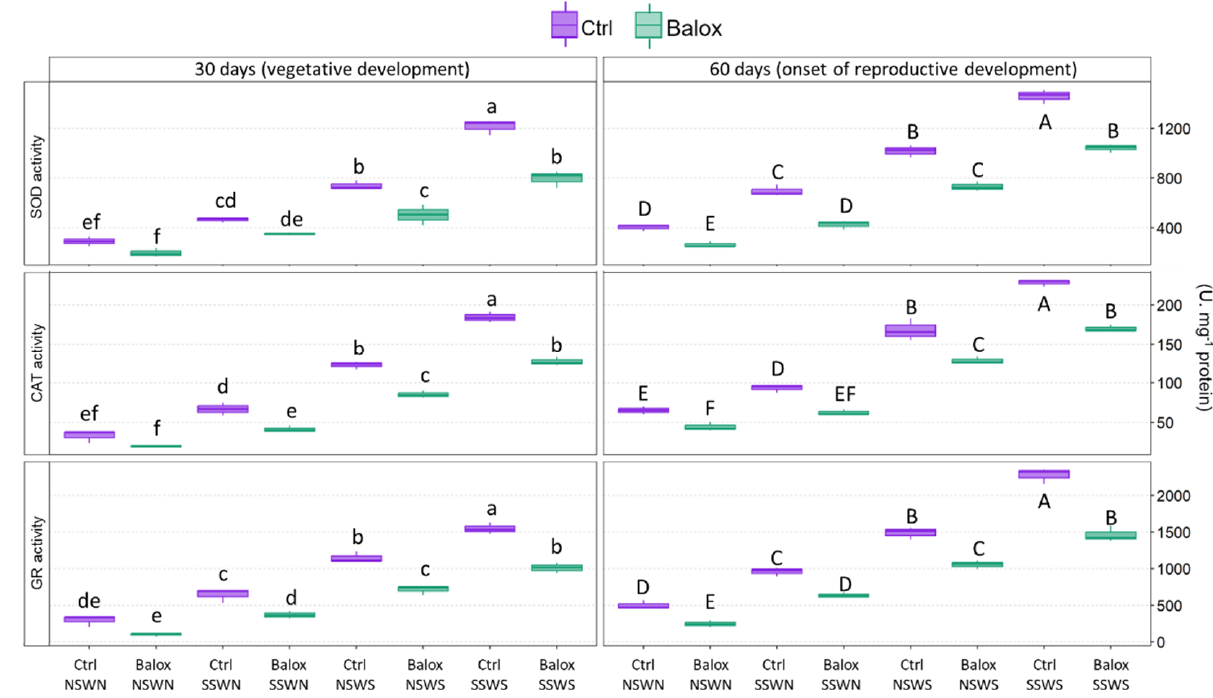
Figure 10. Specific activities of the enzymes superoxide dismutase (SOD), catalase (CAT), and glutathione reductase (GR) in leaf extracts of tomato plants subjected to increasing salinity by different combinations of saline or non-saline soil and irrigation water; the plants were treated, or not, with the biostimulant containing polyphenols at 1.4% ( w / w ) and glycine betaine at 3.0% ( w / w ) at a dose of 0.4 mL L − 1 of irrigation water. The control treatments without biostimulant (Ctrl) and the treatments with biostimulant (BALOX ® ) are defined as follows: (i) NSWN: Non-saline soil (EC = 2.28 dS/m) and non-saline water (EC = 0.91 dS/m); (ii) SSWN: Saline soil (EC = 8.55 dS/m) and non-saline water (EC = 0.91 dS/m); (iii) NSWS: Non-saline soil (EC = 2.28 dS/m) and saline water (EC = 10.50 dS/m); (iv) SSWS: Saline soil (EC = 8.55 dS/m) and saline water (EC = 10.50 dS/m). The evaluation periods: 30 days and 60 days of treatment. The values are the means ± SE ( n = 3). Different letters above the bars (lowercase for 30 days and capital for 60 days of treatments) indicate significant differences between treatments, according to the ANOVA test ( p < 0.05). Statistical analyses were performed independently for the two treatment